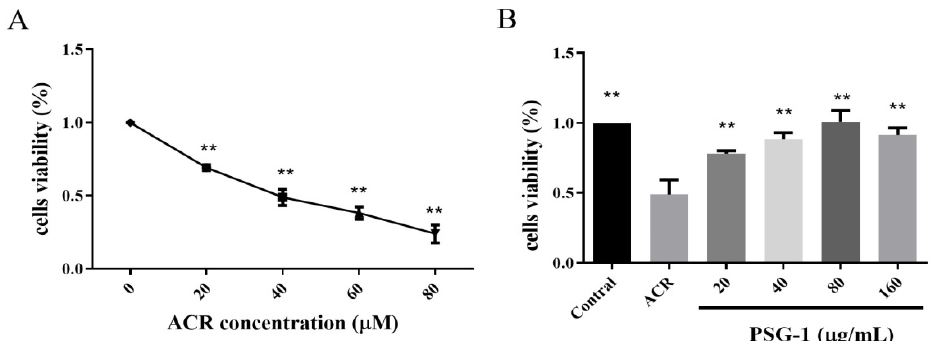
Figure 1. PSG-1 increased cell viability exposed to acrolein. ( A ) Acrolein effect on IEC-6 cells viability. ( B ) Effect of PSG-1 on acrolein-induced IEC-6 cells viability. Values are means ± SD ( n = 3), ** p < 0.01 compared with the acrolein group.